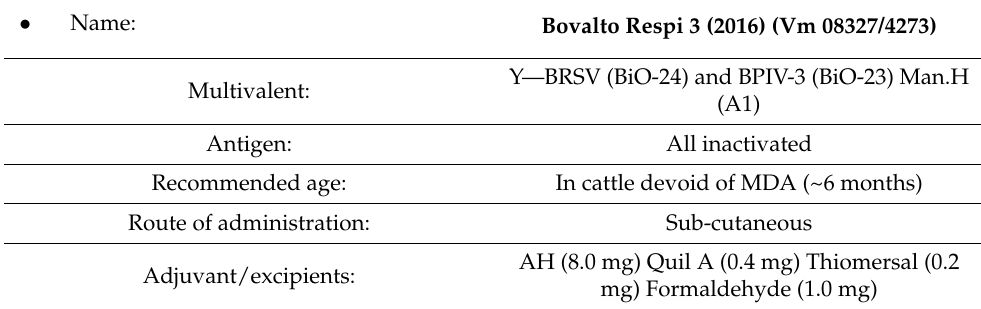
Table A2. Poly/Multivalent vaccines for bovine respiratory